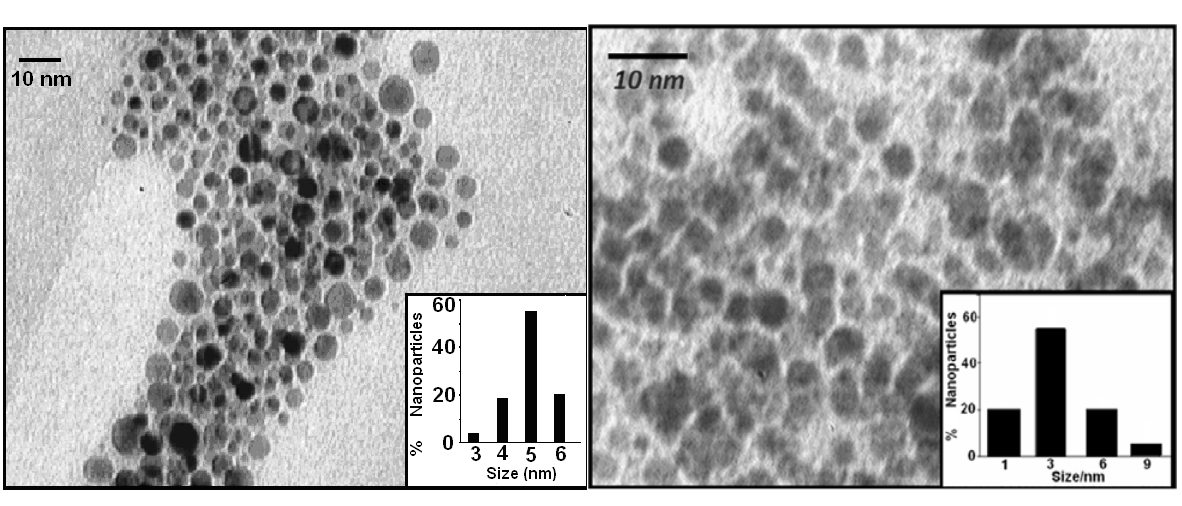
Figure 7. Transmission electron microscopy (TEM) photograph of Au nanoparticles in the two nanocongugates (Left: Folate-4Atp-AuNP; Right: Folate-MH-AuNP). Insets: histograms for the size distribution of the Au nanoparticles [25-29].